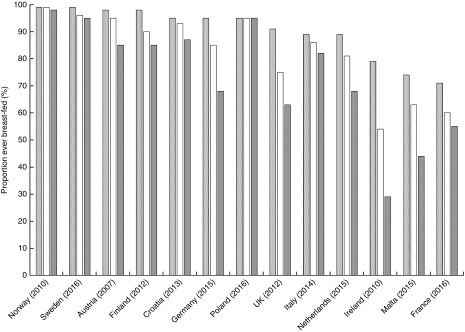
Any breast-feeding rate according to high (), middle () and low () maternal education levels in twelve EU countries plus Norway, 2006–2016